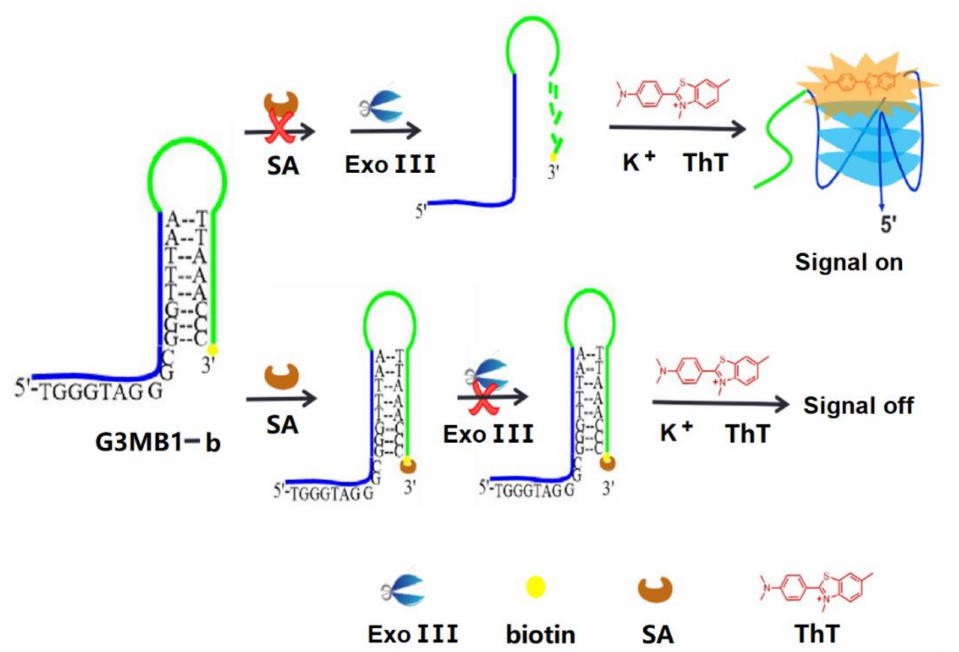
Scheme 1. Illustration of the G3MB1-b based on the G-triplex DNA and thioflavin T for strepta- vidin